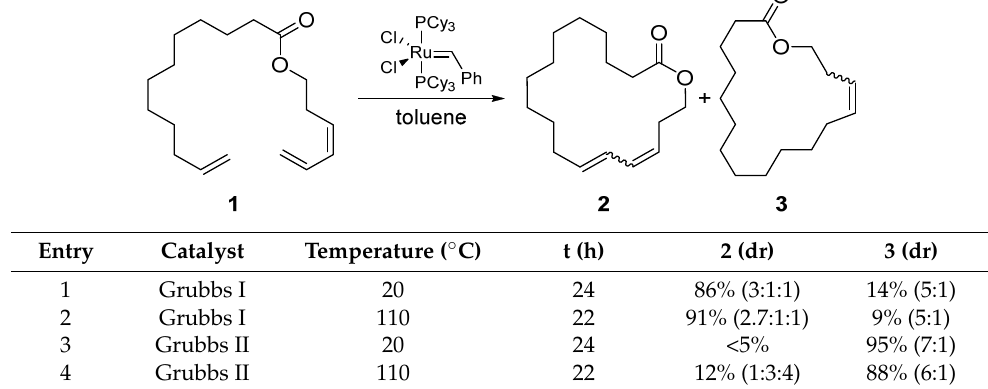
Table 3. Metathesis by ring closure with the 1st generation Grubbs catalyst.